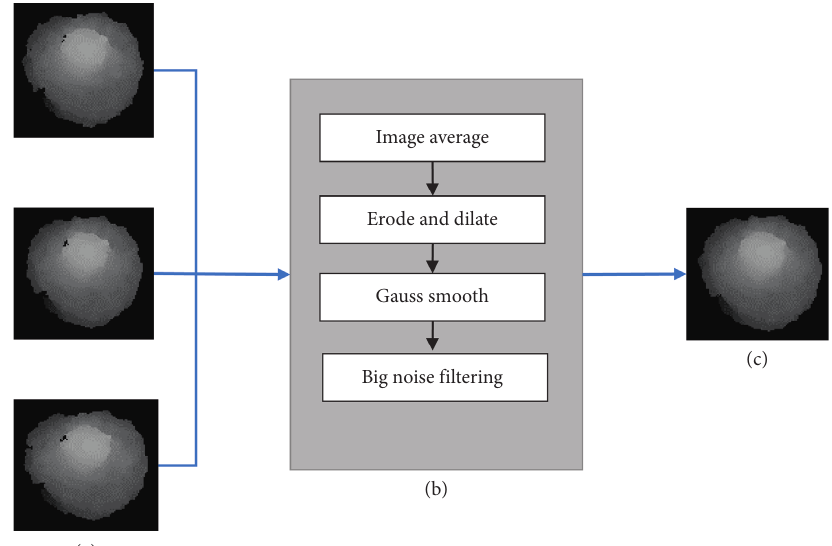
Figure 3: Depth image preprocessing flowchart. (a) Three enhanced potato surface depth images. (b) Potato image processing module. (c) Enhanced potato surface depth image.